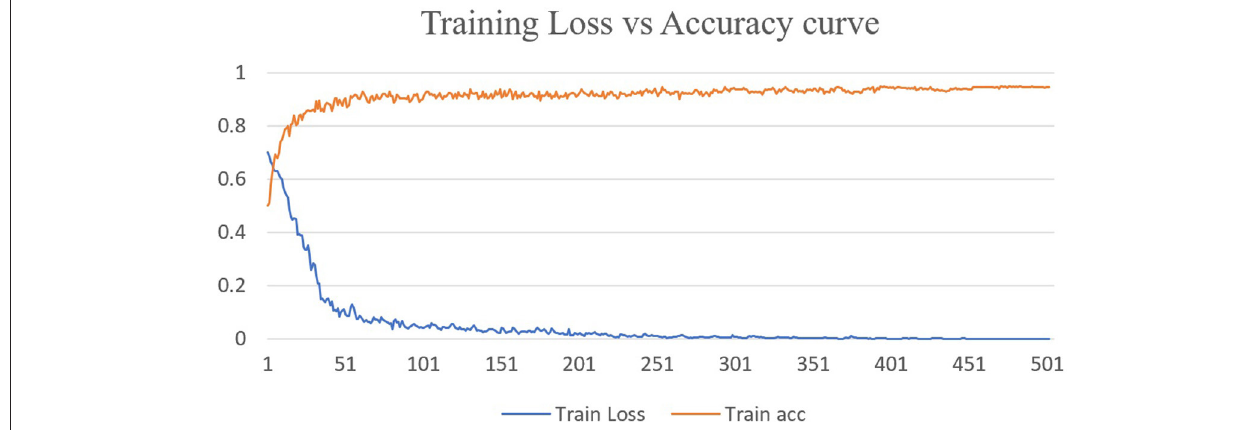
FIGURE 5 | Training loss vs. accuracy curve for DarkASDNet.